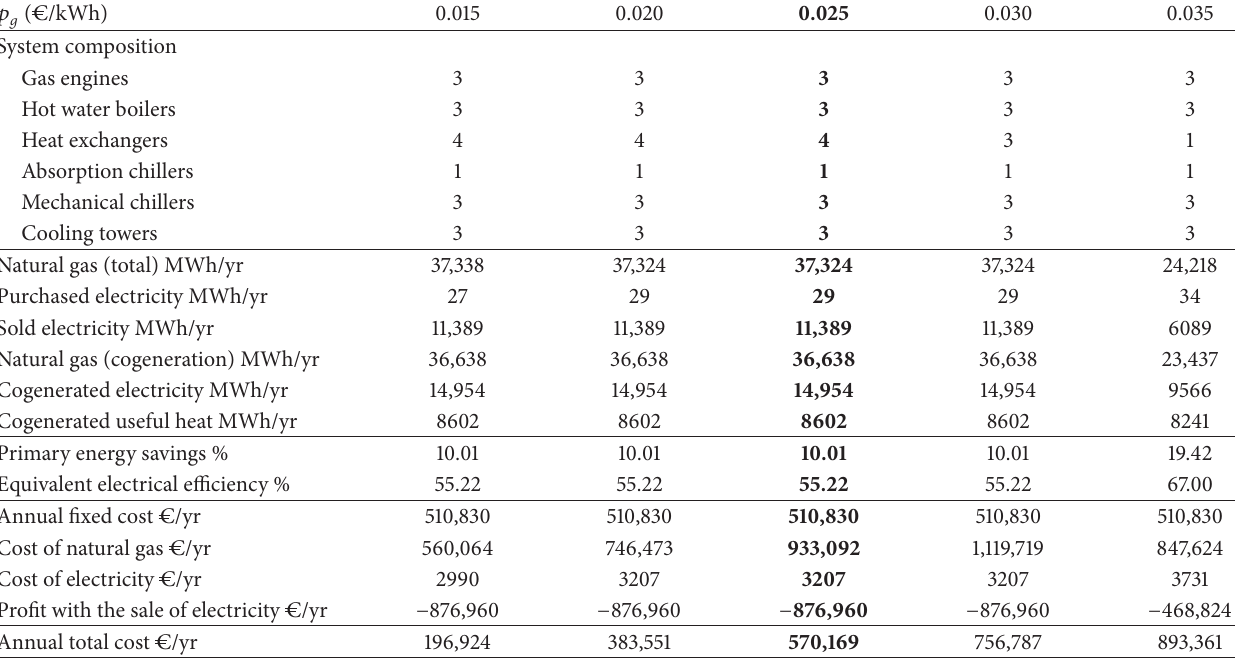
Table 8: Sensitivity analysis for natural gas price considering the base case configuration.